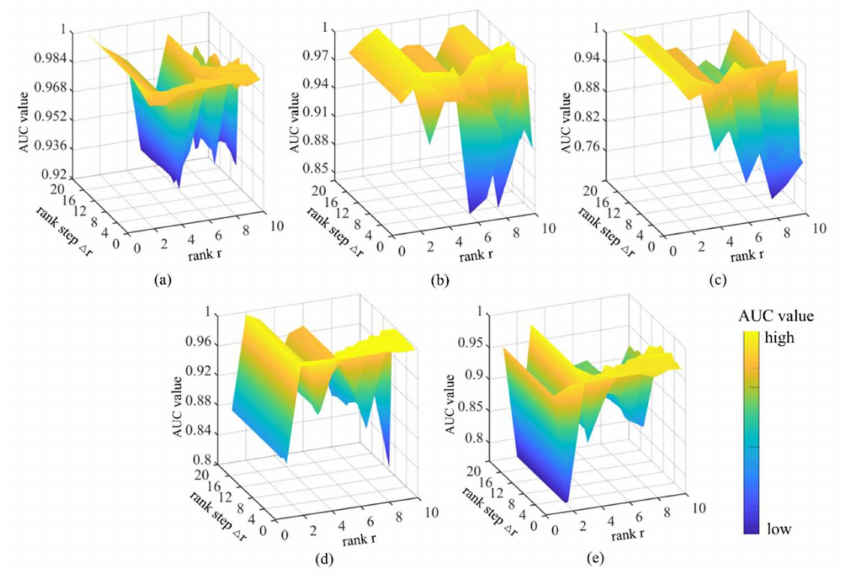
Figure 16. AUC values of GBSAED according to changes in rank step ∆ r and rank r : ( a ) Texas Coast Image, ( b ) Belcher Bay Image, ( c ) PaviaC Image, ( d ) San Diego Image, and ( e ) Xiong’an Image.